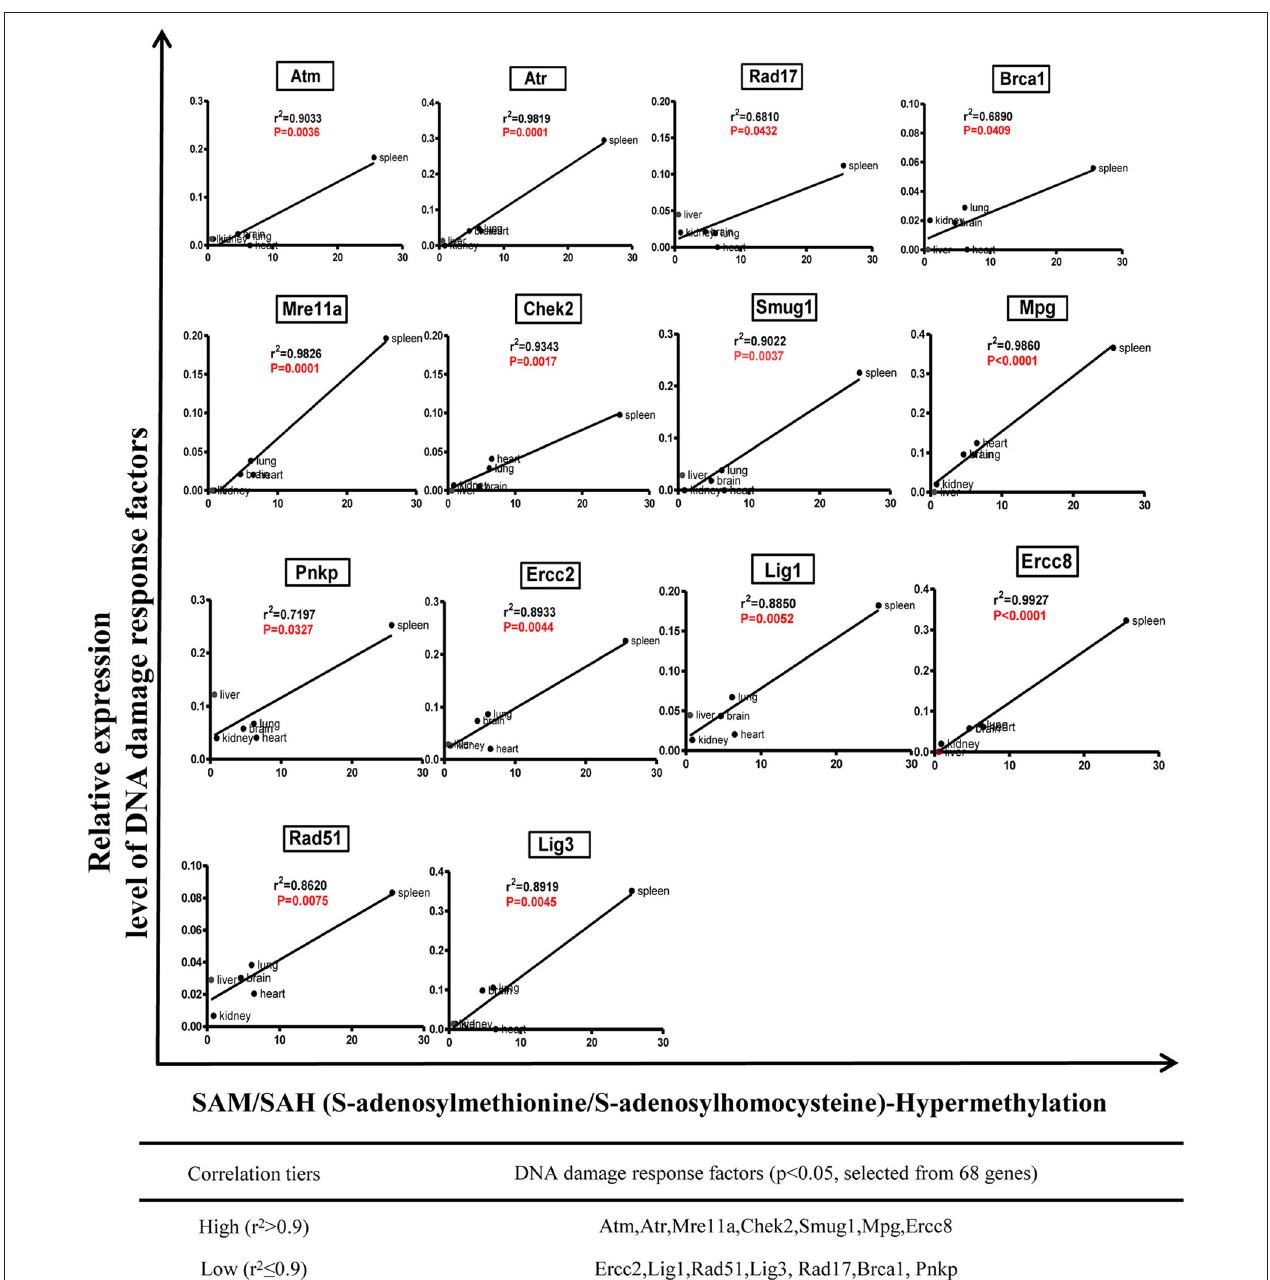
FIGURE 10 | Tissue SAM/SAH ratio may regulate DNA damage response factors expression in mouse